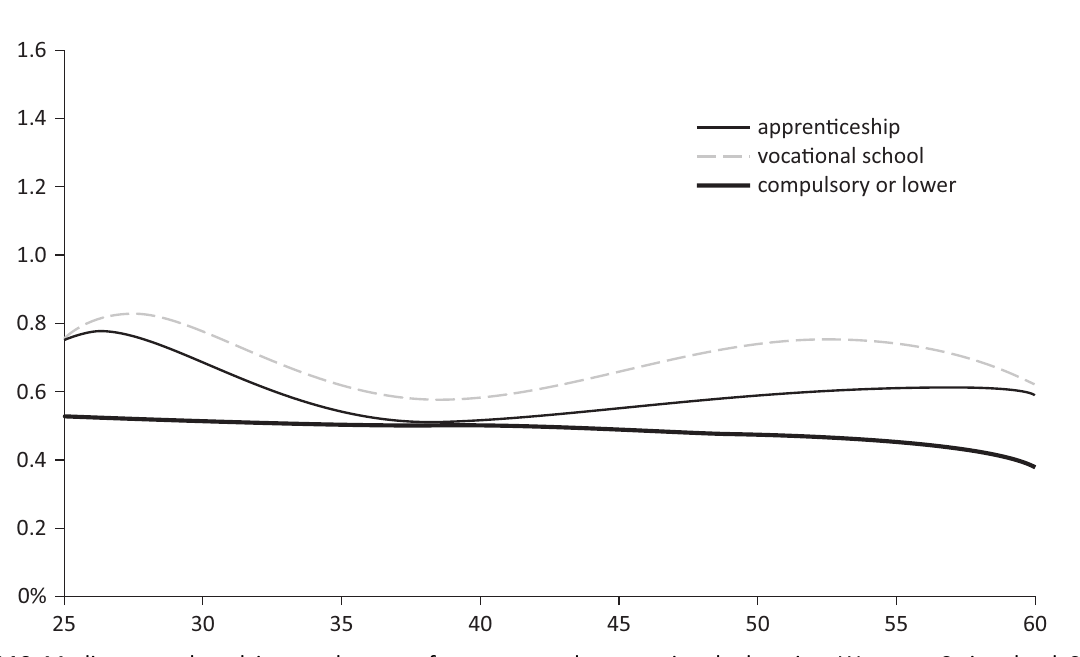
Figure A10. Median annual work income by type of upper-secondary vocational education. Women—Switzerland. Source: Swiss Labour Force Survey 1991–2014. Note: 1 = Median annual work income for CH